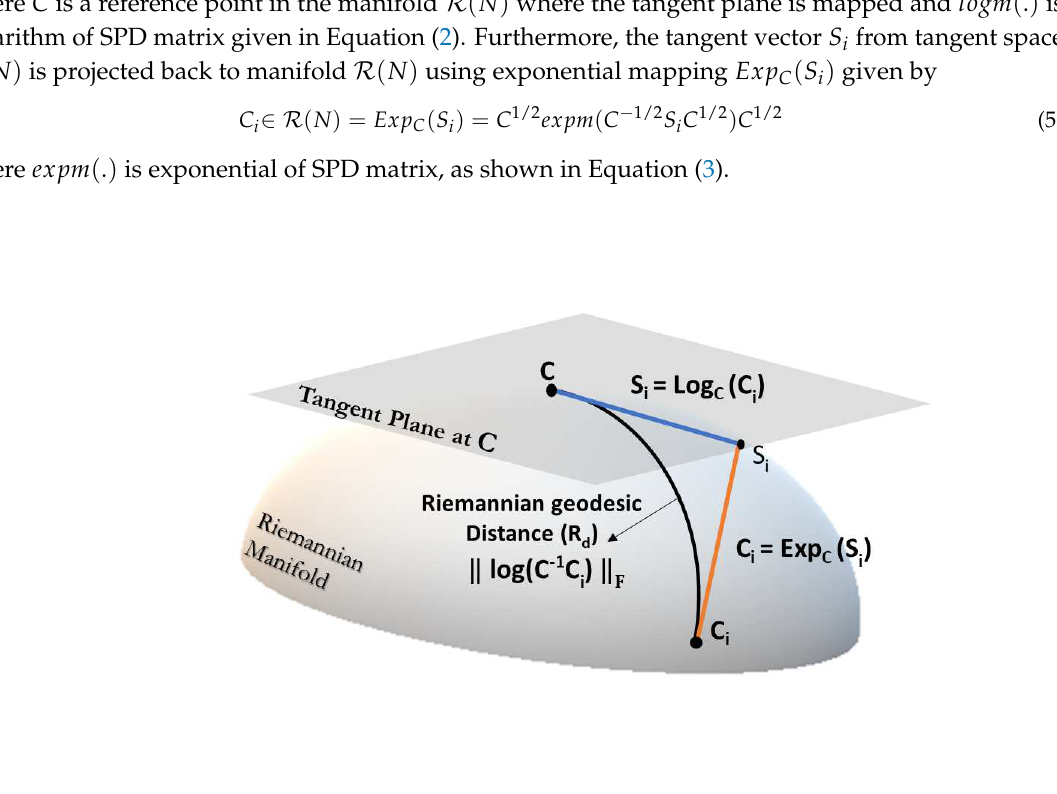
Figure 1. Illustration of Tangent space at point C . Tangent vector S i is the projection of C i and R d is the geodesic between C and C i